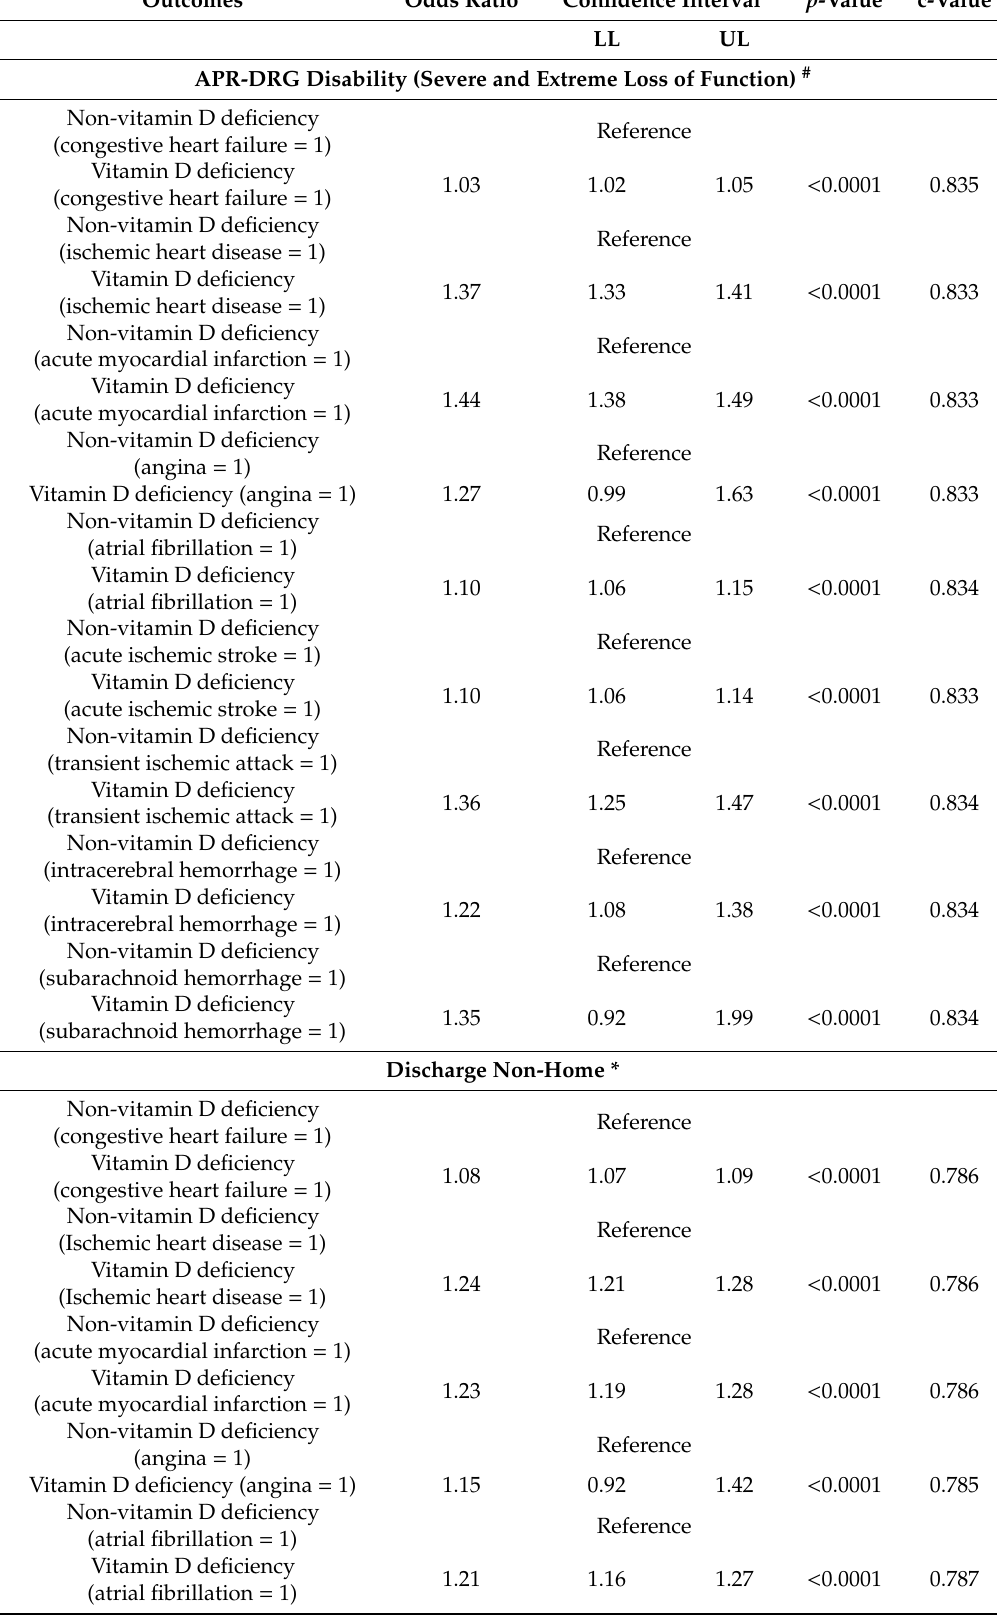
Table 4. Multivariable regression analysis of predictors of poor outcomes of cardiovascular diseases and cerebrovascular disorders among vitamin D deficiency